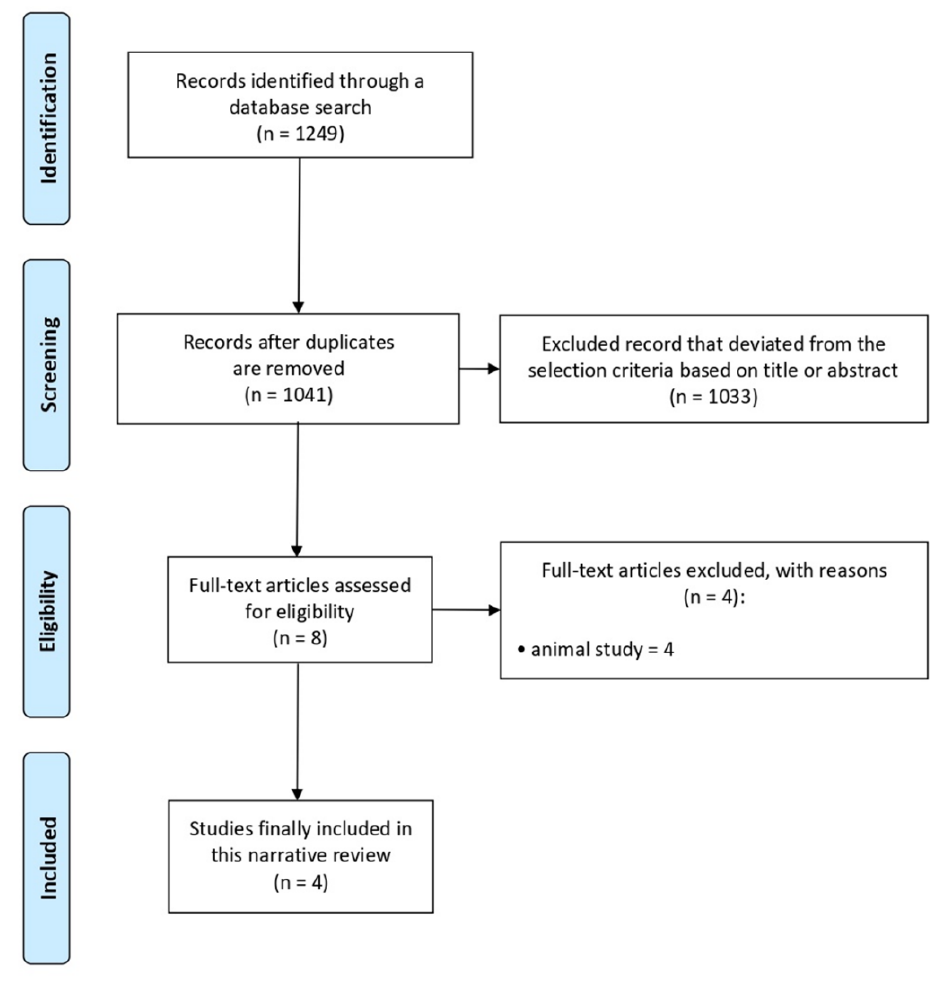
Figure 1. Flow chart of the selection process of relevant publications.